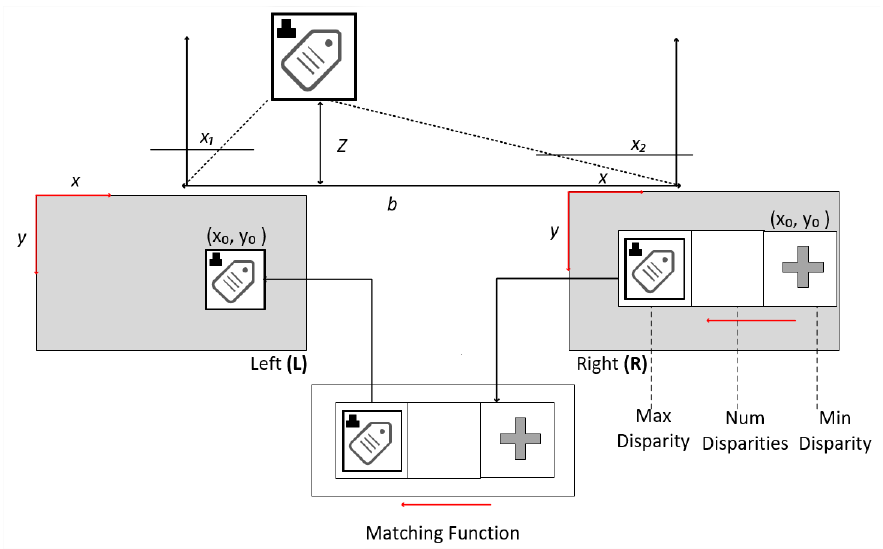
Figure 7. Systematics of the disparity map operation.